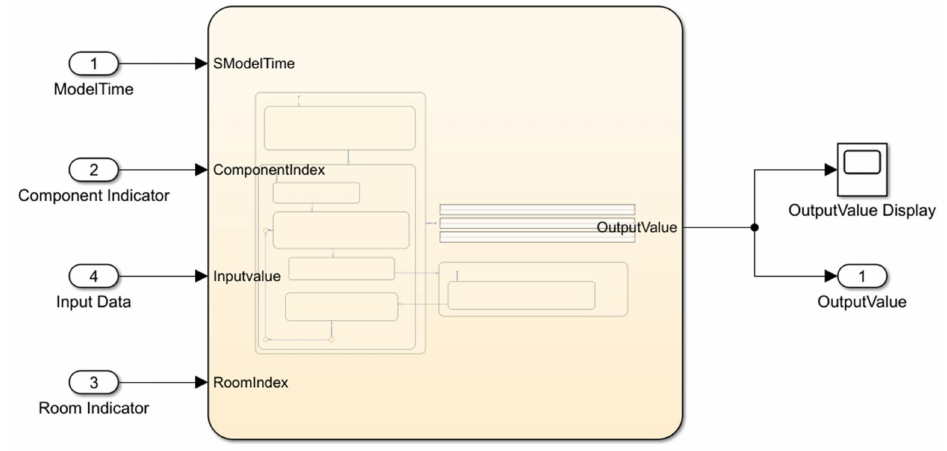
Figure 7. The exterior view of the Stateflow